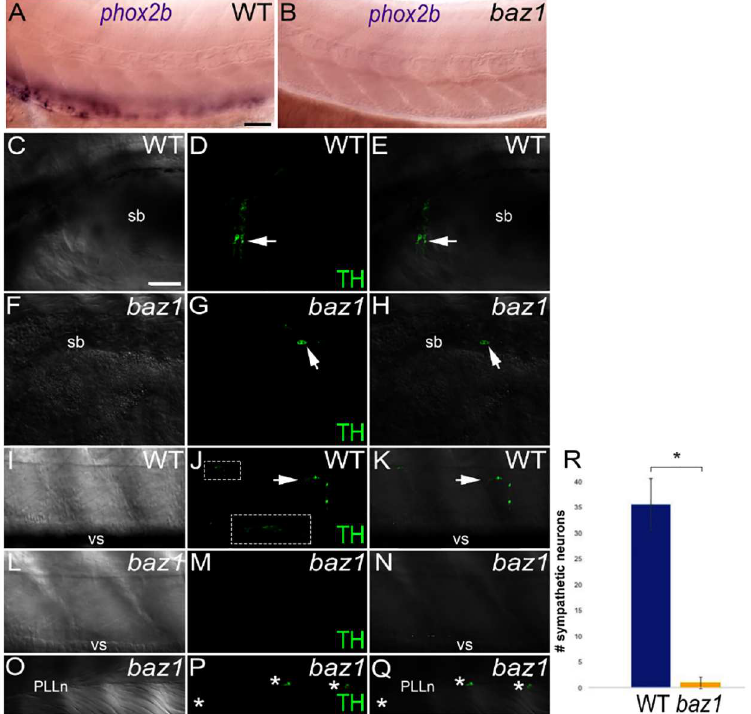
Fig 2. Enteric precursors are absent in baz1 mutants and supernumeraryneurons in trunk and tail do not express markers of non-sensory neuronal types. A,B) phox2b expressionat 72 hpf in wild-types(A) is restricted to the enteric neuronprogenitors, but is absent from baz1 embryos (B). Tyrosine hydroxylase(TH) immunofluorescencerevealsdifferentiated sympatheticneuronsat 7 dpf in WT (C-E, I-K), whereasthese are much reducedin baz1 mutants (F-H, L-M). White arrows indicatea subset of TH + neurons. Inset in J represents enlargementof boxed area to show autonomic neuronchain more clearly. Occasional baz1 mutants show anti-TH immunofluorescence in neurons ( * ) associated with the PLLn (O-Q). DIC (C,F,I,L,O) and immunofluorescent TH images (D,G,J,M,P) are mergedin panels E,H,K,N,Q respectively. sb, swim bladder;vs, ventral stripe. R) Quantitation (mean ± s.d.) of anti-TH positive sympathetic neuronsin WT (N = 16) and baz1 mutants (N = 16). * indicatessignificantdifference (two-tailed t test, p < 0.001)Scale bar, 50 μ